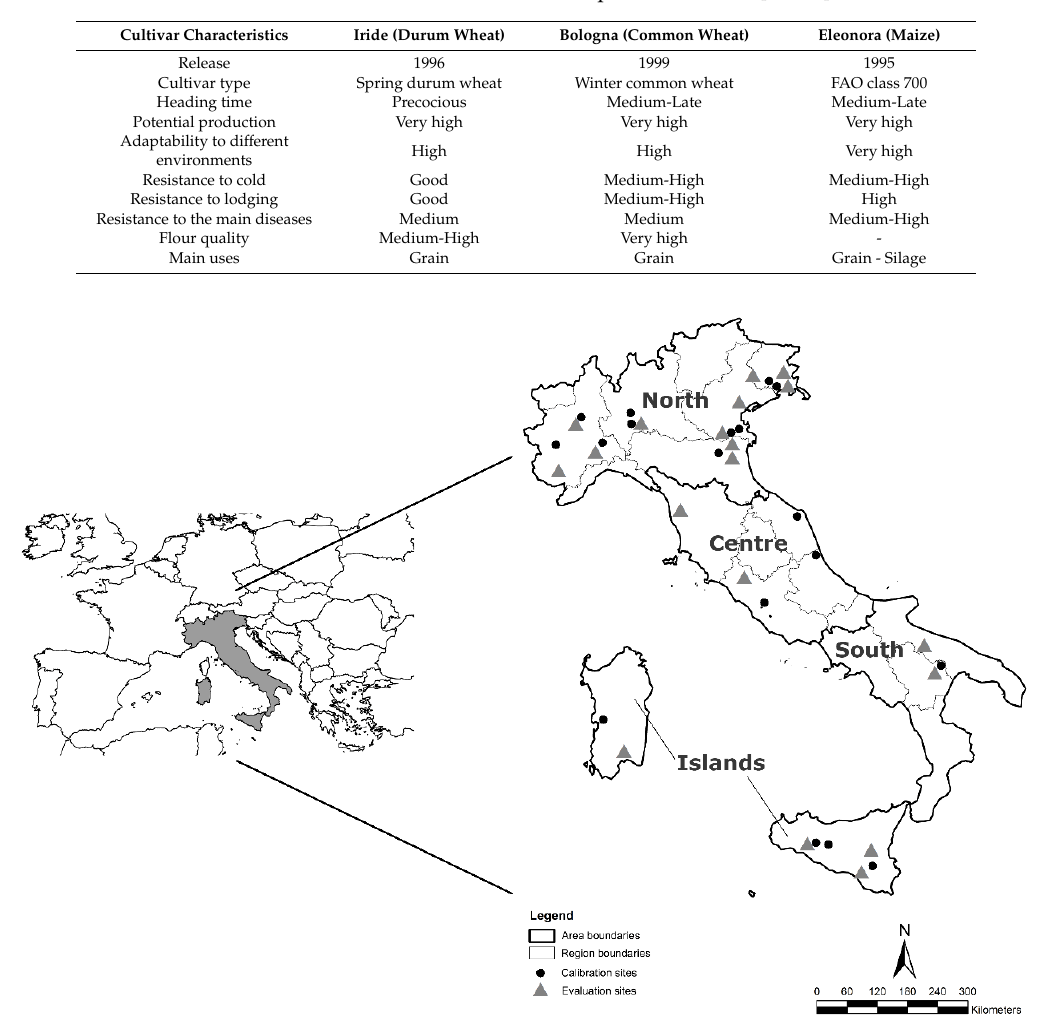
Figure 1. Location of the experimental sites for model calibration and evaluation in Italy. The crop varieties were selected as representative of very-high productivity potential The main characteristics of each experimental site are given in Table 3. Table 3. Characterization of the experimental sites.